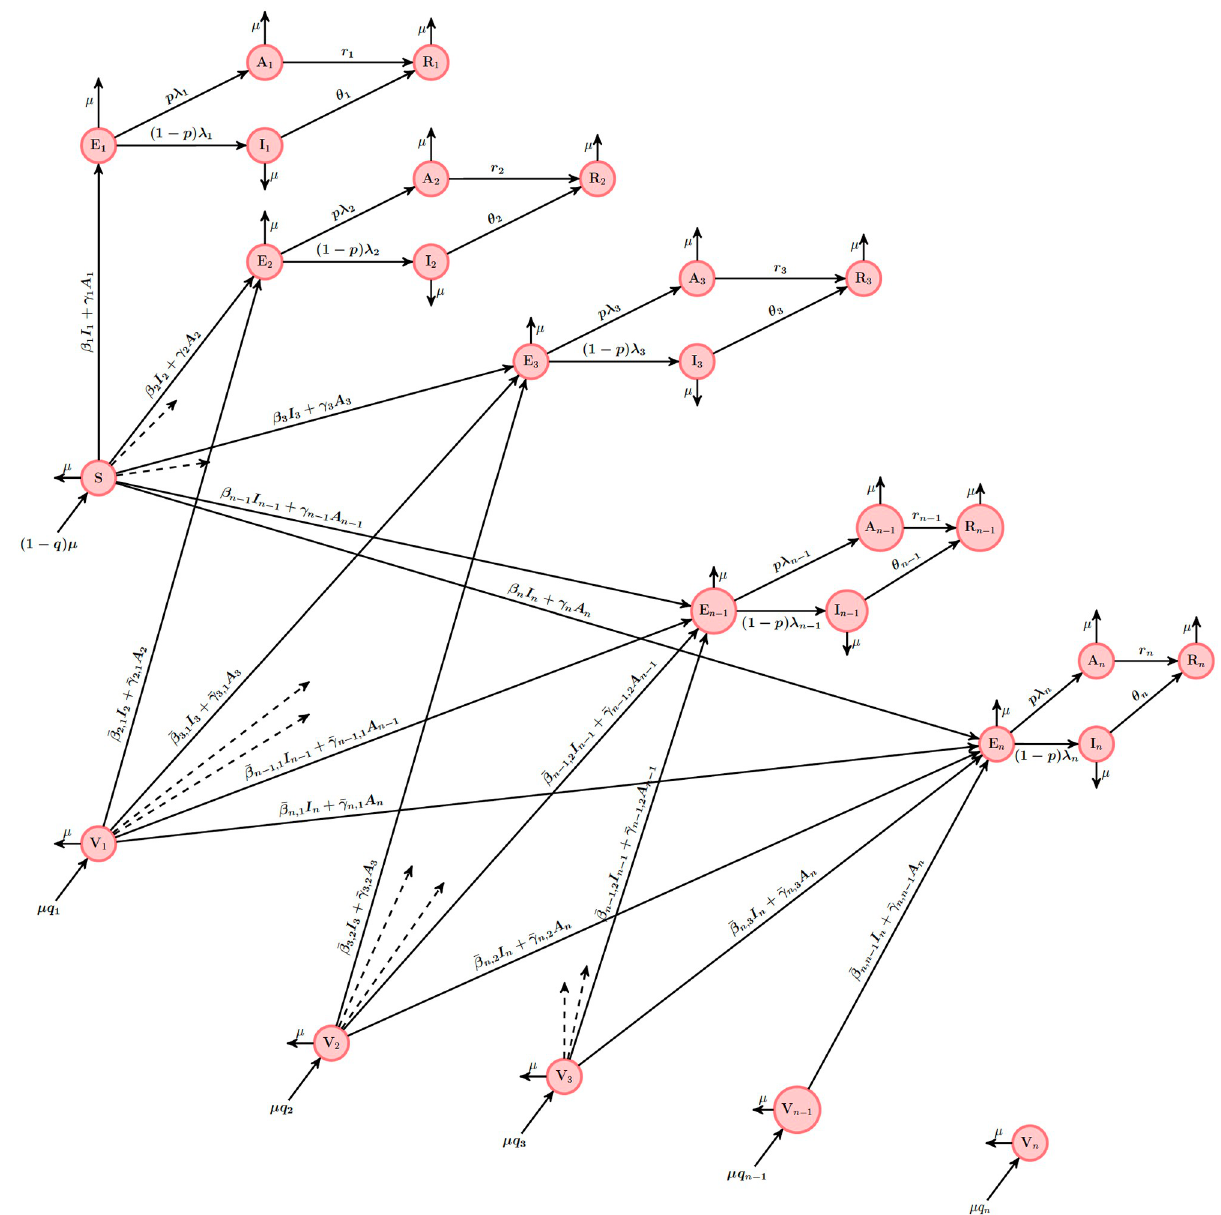
Fig 1. Schematic diagram for the epidemic model (1). The circle compartments represent group of individuals.